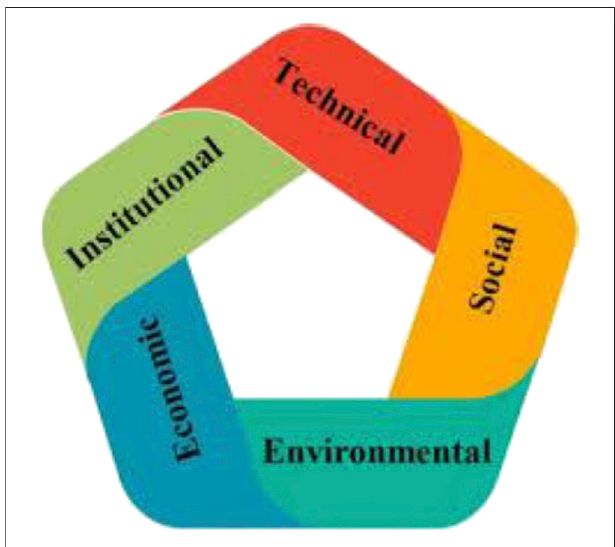
FIGURE 8 | Dimensions of energy sustainability (Kabeyi,